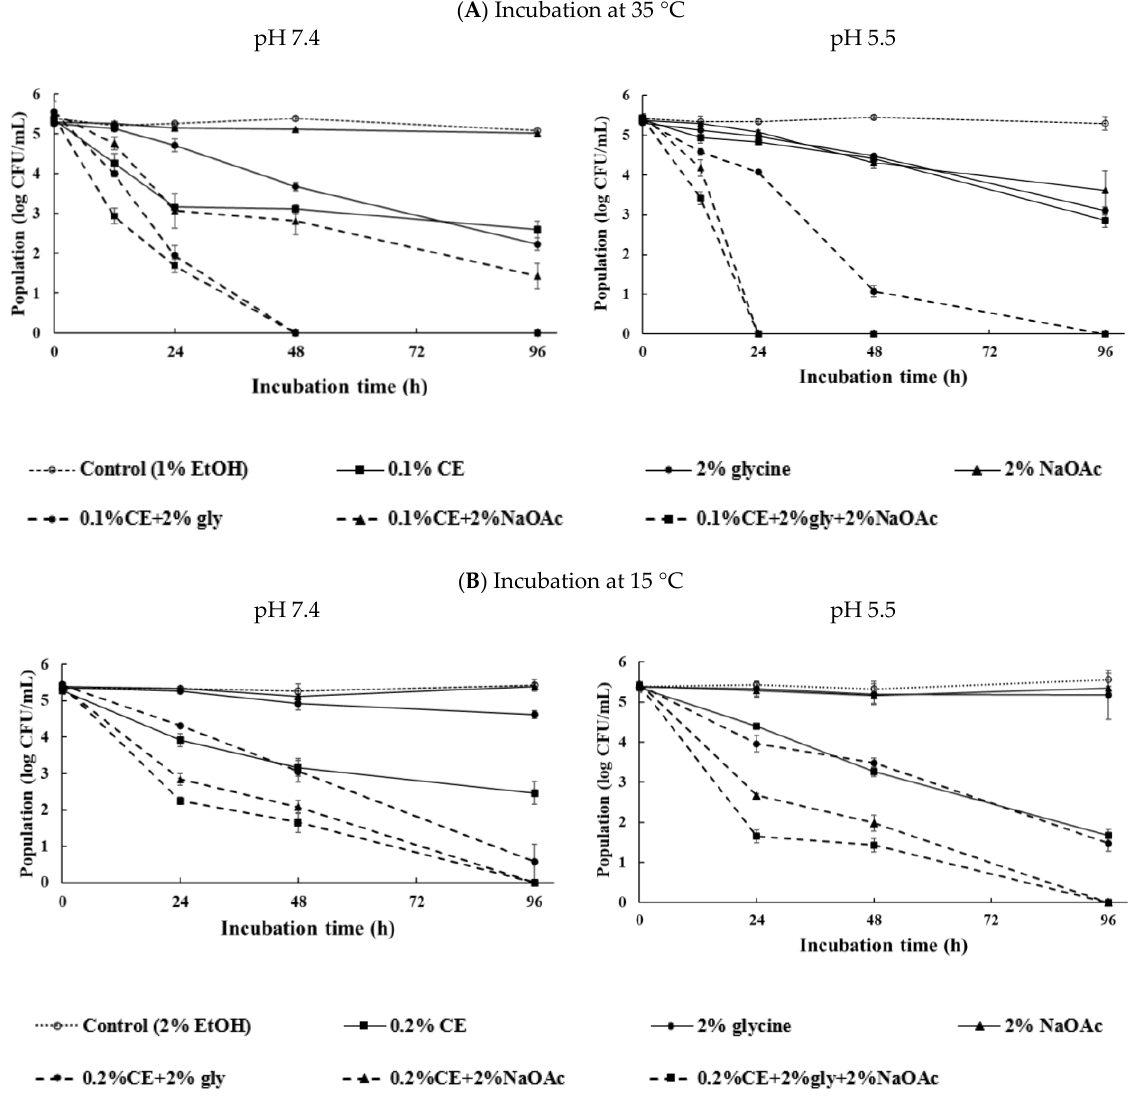
Figure 2. The survival of E. coli O157:H7 in PBS containing individual and/or in combination of clove extract, glycine, and NaOAc incubated at ( A ) 35 ◦ C and ( B ) 15 ◦ C; pH 7.4 (left side) and pH 5.5 (right side). Values of each treatment are mean ± SD (n =